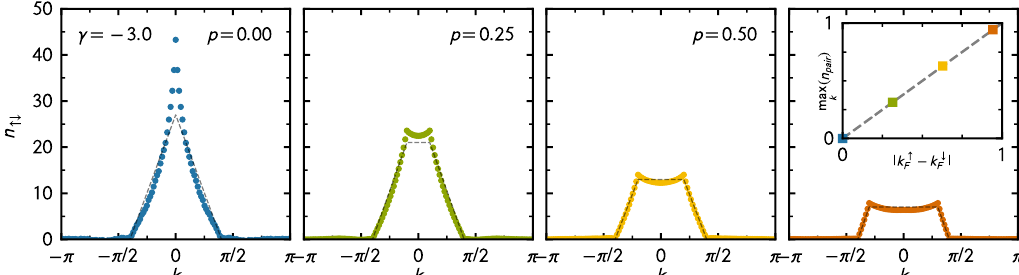
Figure 3: Pair-momentum distribution n ↑↓ in the first Brillouin zone for systems of fixed density n = 0.4 and polarizations of p = 0.0,0.25,0.5 and 0.75 (from left to right). A clearly visible maximum / peak away from the point k = 0 emerges for any non-zero polarization. The gray dashed lines reflect the non-interacting system. Inset of rightmost panel : The dependence of the position of the maximum (for k > 0) on the polarization in form of the difference | k agreement with the FFLO prediction. The statistical error bars are smaller than the symbol